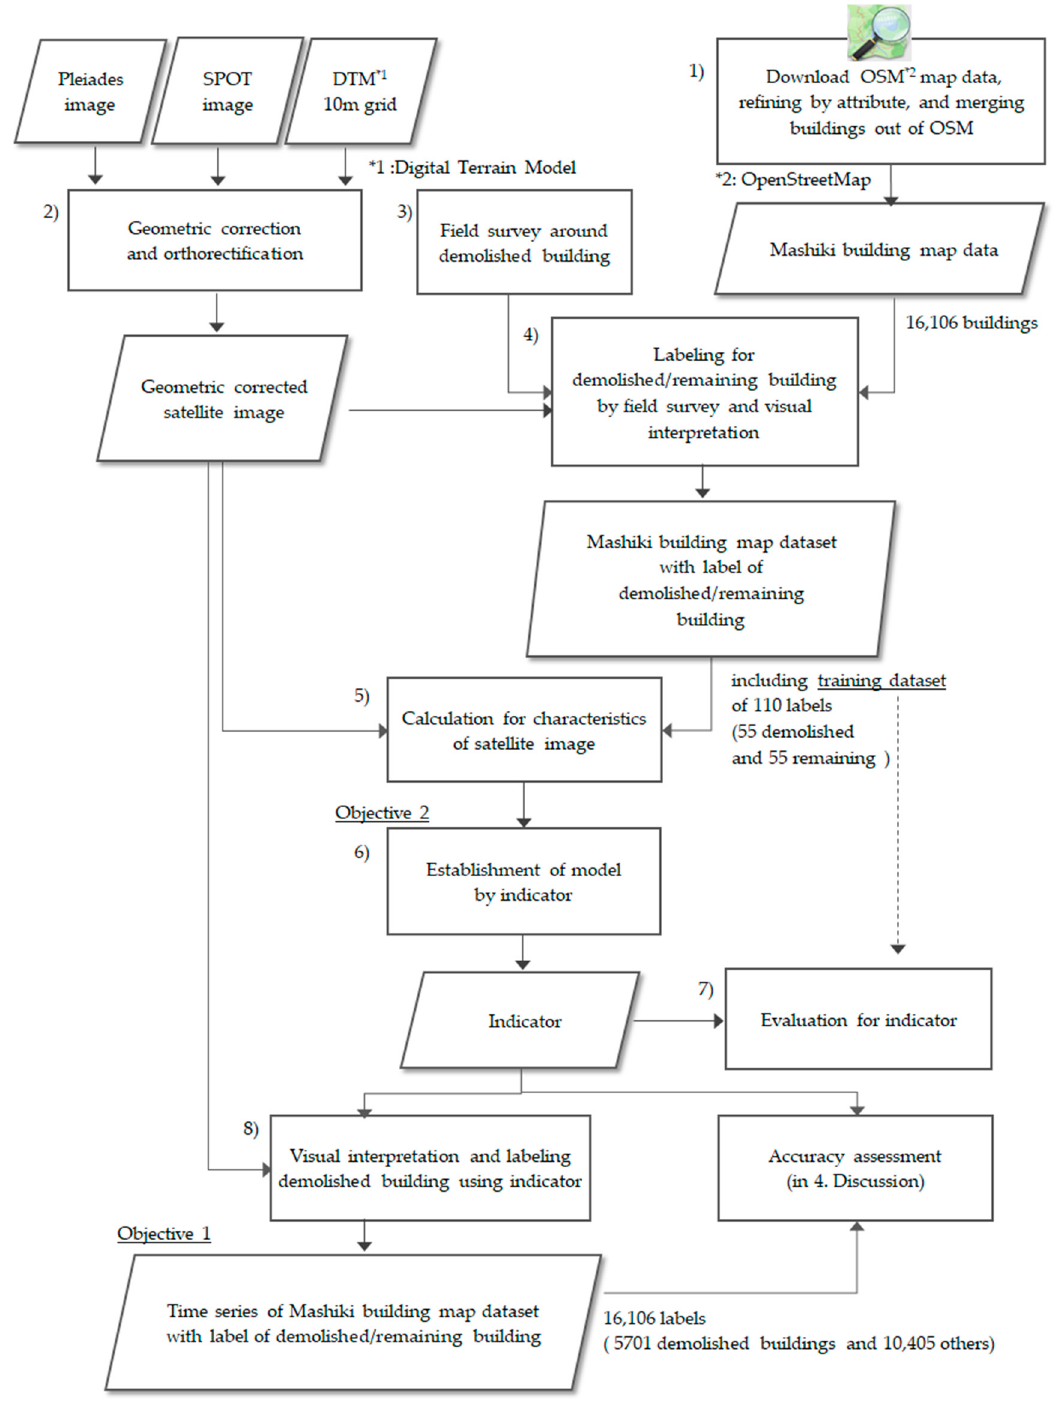
Figure 2. Work flow for the establishment of the analysis model and dataset of demolished/remaining buildings.